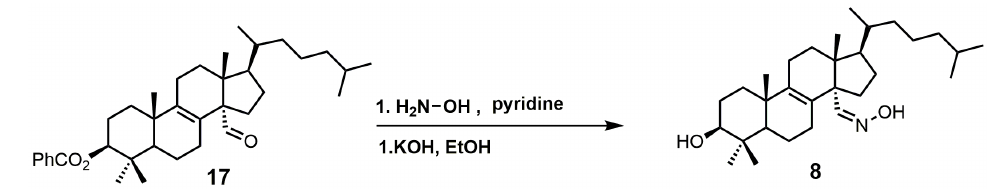
Figure 7. The synthesis of lanost-8-en-32-alkoxime-3 β -ol ( 8 ).